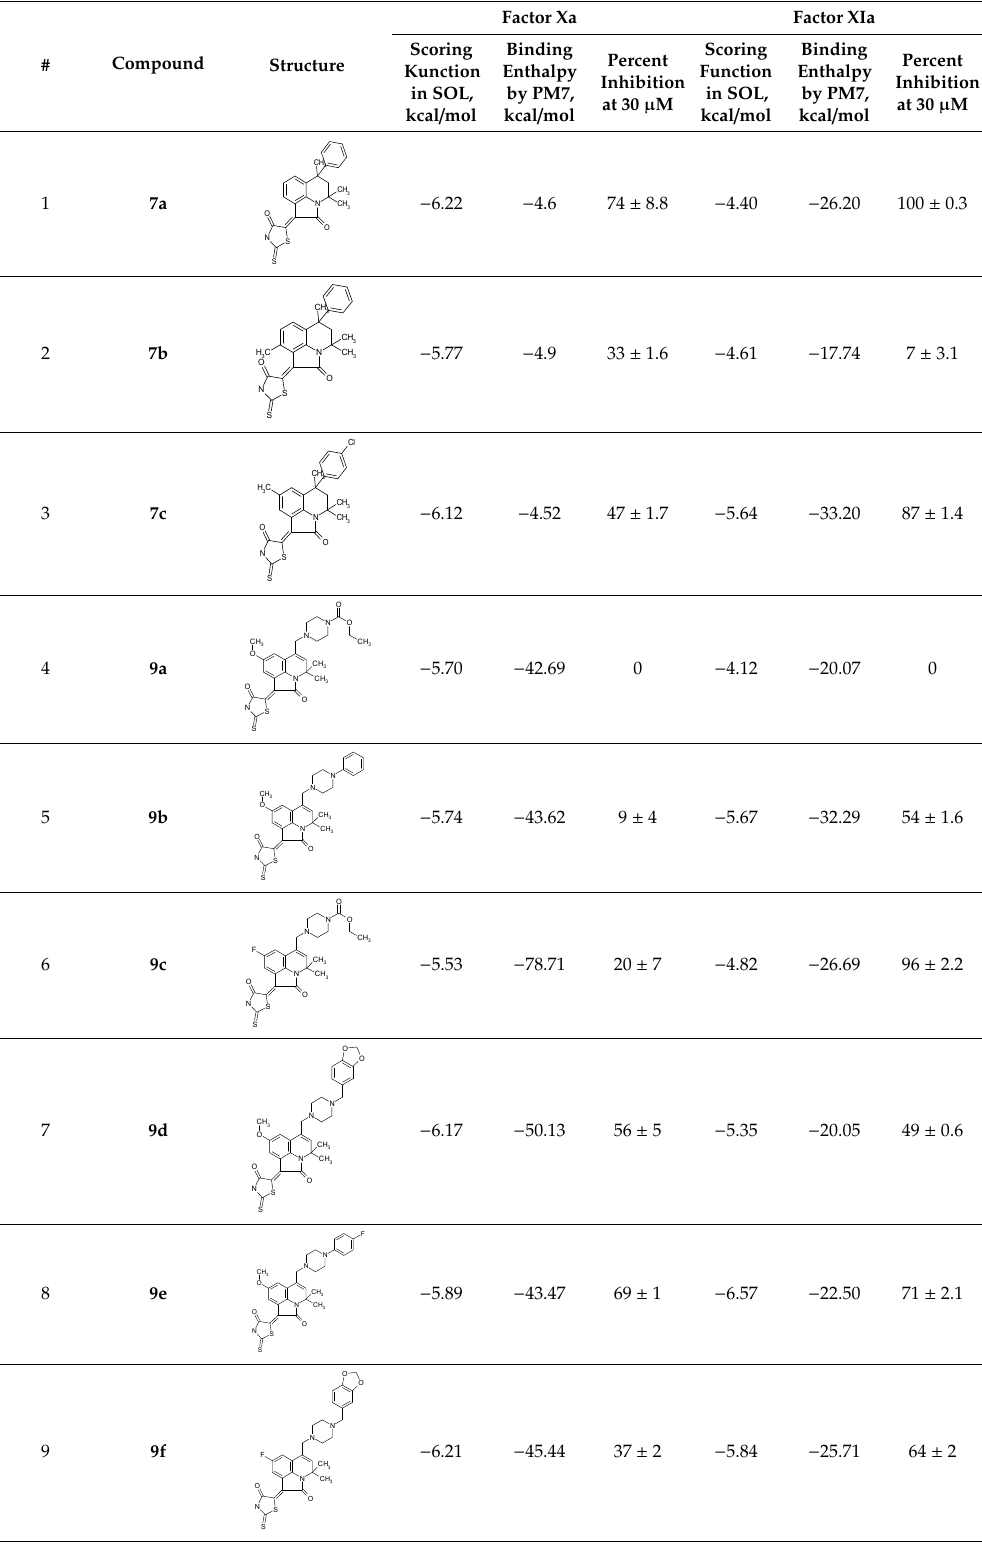
Table 1. Predicted and observed inhibition values for the nine synthesized derivatives of PQ against FXa and FXIa. The larger the value of percent inhibition, the more active the ligand.